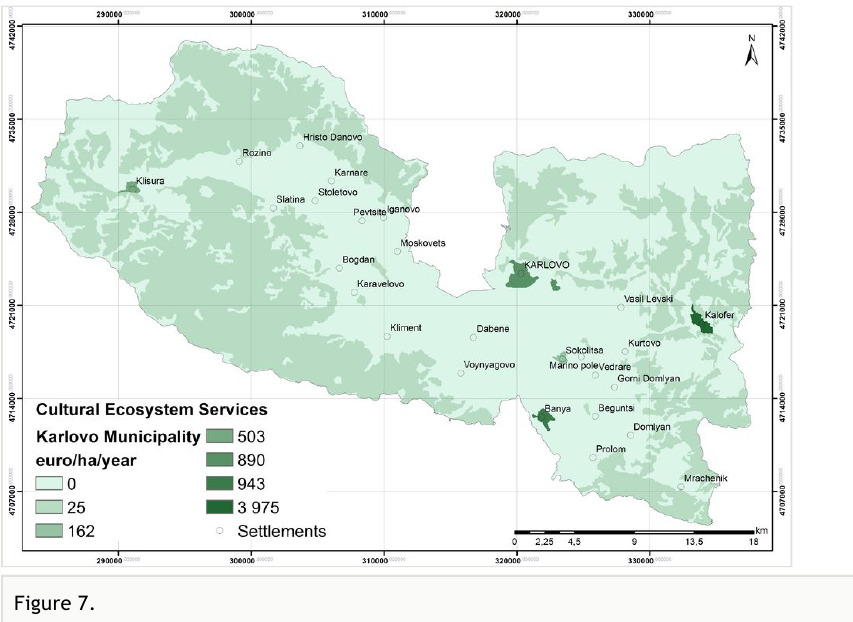
Economic Value of Cultural Ecosystem Services in Karlovo